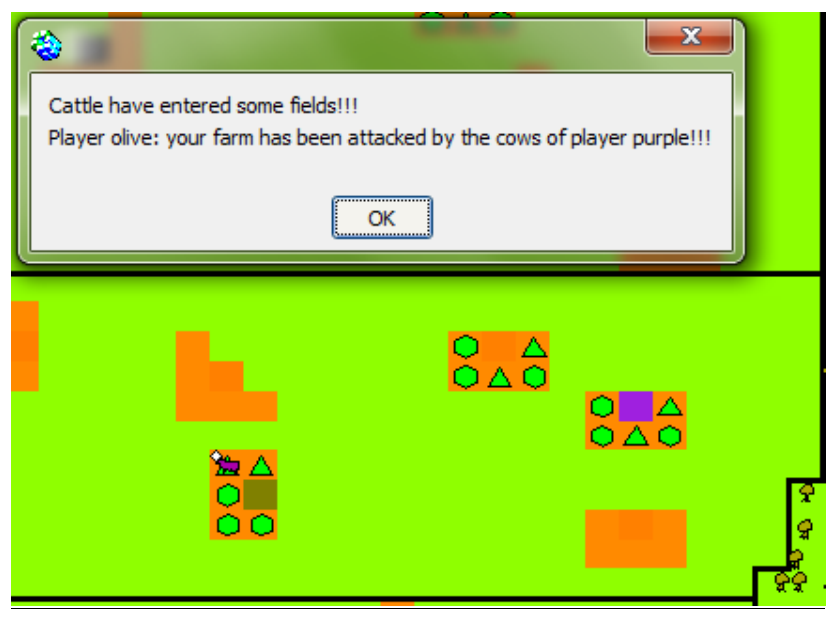
Figure 10. Cattle entering a Field. The cattle of the purple player were left alone to graze in this communal paddock containing growing fields. They entered a growing field of the olive player. The white lozenge on the corner of the field of the olive player signifies a loss of